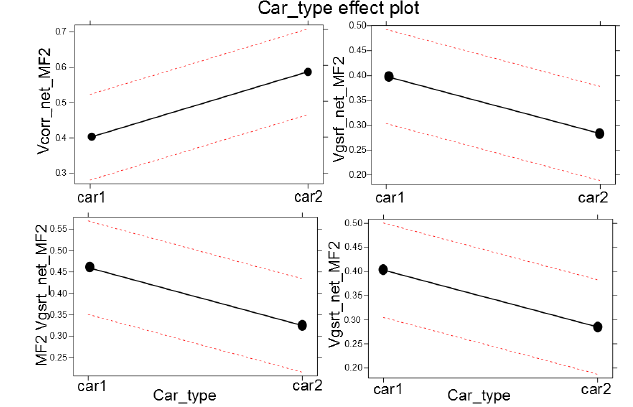
Figure 7. Interaction effects